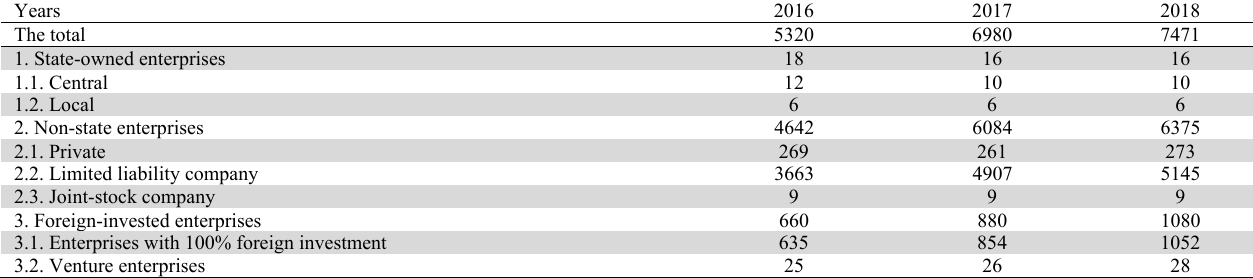
The scale of enterprises by types of enterpris (Unit: